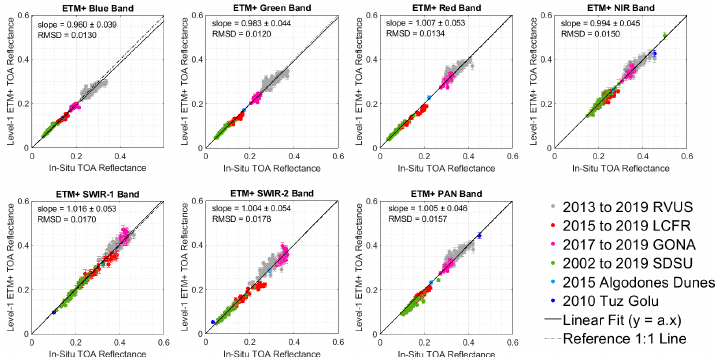
Figure 11. Scatterplots by band of Landsat-7 ETM+ Level-1 TOA reflectance data versus TOA reflectance derived from in situ measurements.